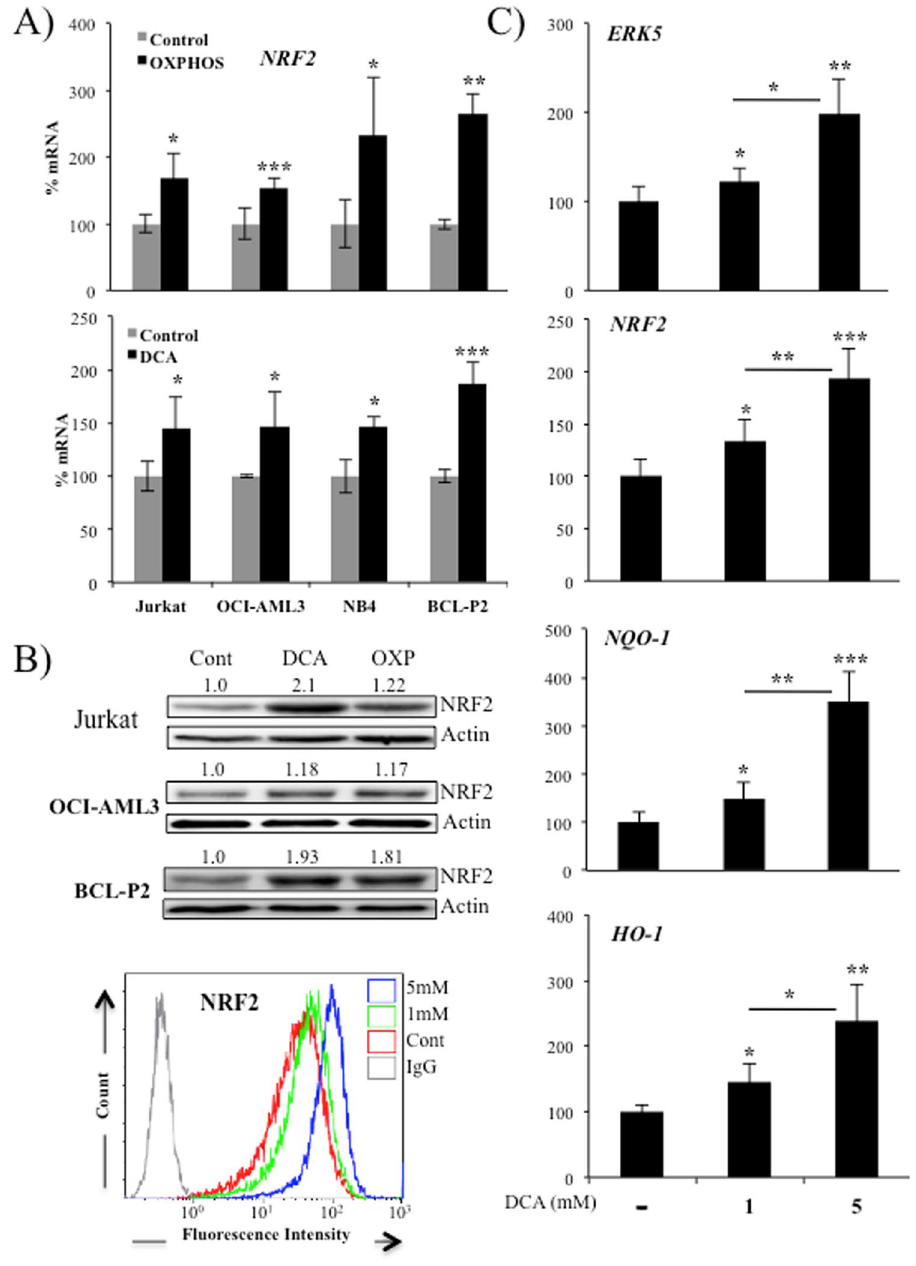
Figure 1. Cells performing OXPHOS upregulated NRF2 expression. ( A ) Different hematopoietic cells were incubated in OXPHOS medium or treated with 5 mM DCA for 2 weeks. NRF2 mRNA was quantified by qPCR and values normalized to β -actin mRNA. Results were represented as the % of mRNA compared to cells growing only in glucose medium. Bars show average ± SD of 3 independent experiments performed in triplicate. ( B ) NRF2 protein expression was analyzed in several cell lines by western blotting (upper panel) or by flow cytometry in OCI-AML3 cells. ( C ) Hepatocytes from 4 donors were treated with the indicated concentration of DCA for 24 h and ERK5 , NRF2 , NQO-1 and HO-1 mRNA were analyzed. Bars show average ± SD of the four donors performed in